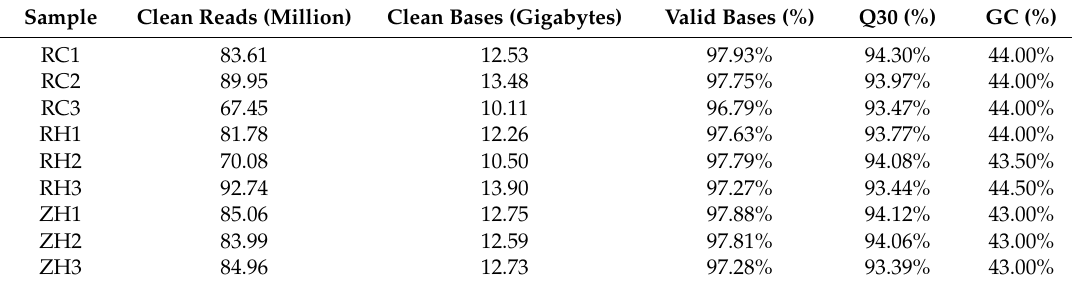
Table 2. Quality assessment of raw RNA-seq